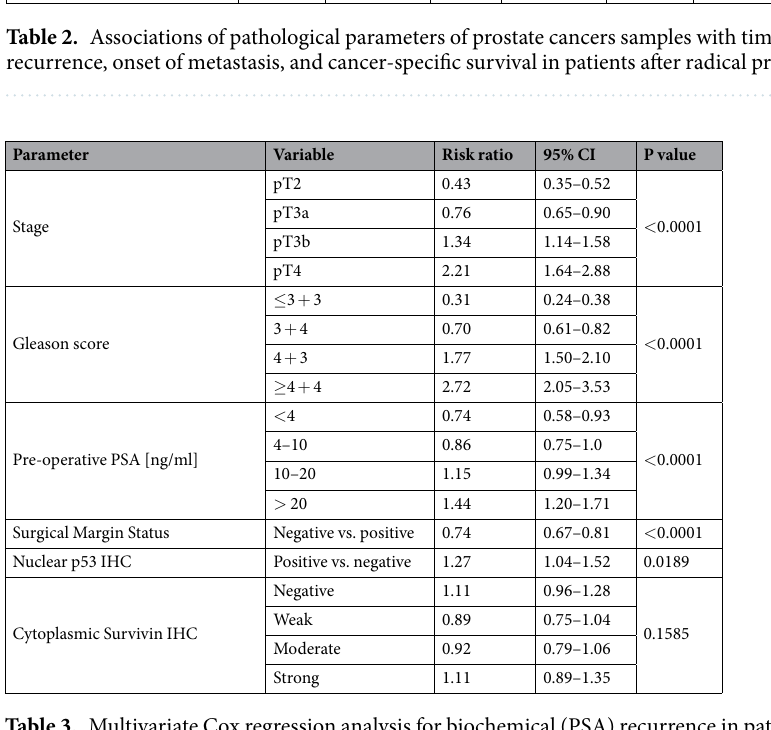
Table 3. Multivariate Cox regression analysis for biochemical (PSA) recurrence in patients after radical prostatectomy.